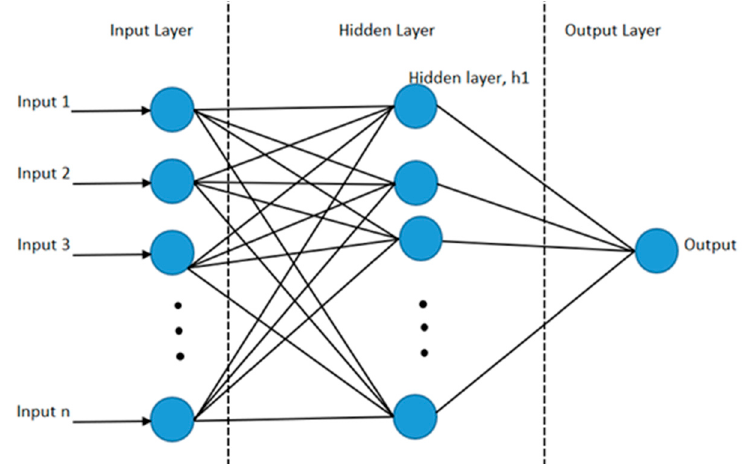
Figure 23 . Artificial neural network architecture framework .